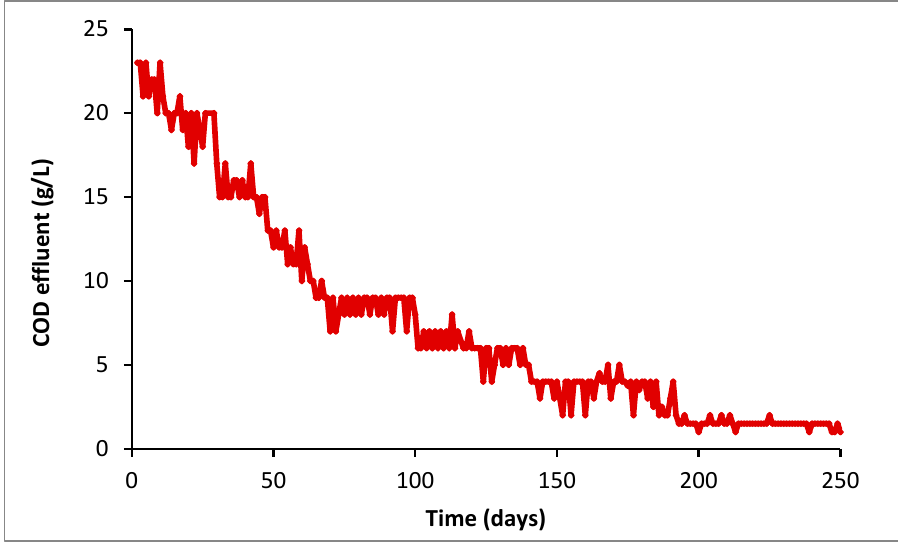
Figure 5. Evolution of total COD of e ffl uent from UASB reactor digesting EF-pretreated sludge.